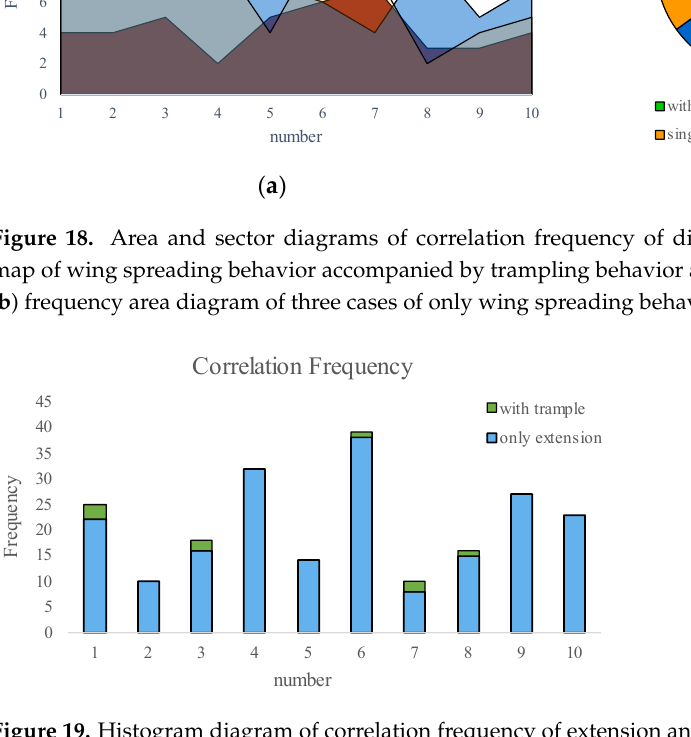
Figure 19. Histogram diagram of correlation frequency of extension and trample.